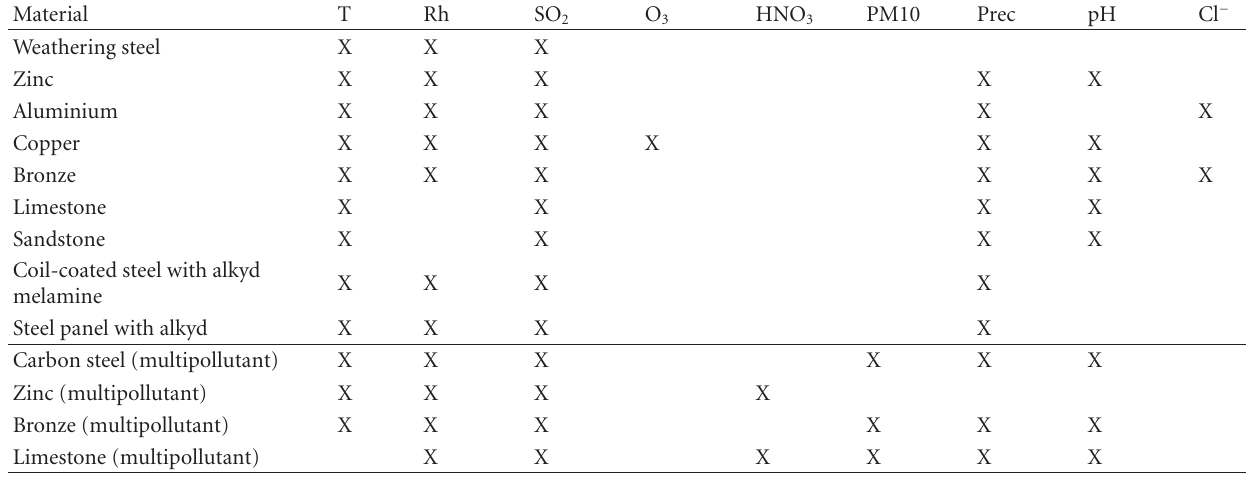
a Calculated from sunshine hours and latitude. b Only data at a few test sites reported. Table 3: Materials for which dose-response functions are given for the SO 2 dominating situation (top) and the multipollutant situation (bottom) in the UNECE Mapping Manual and the required environmental